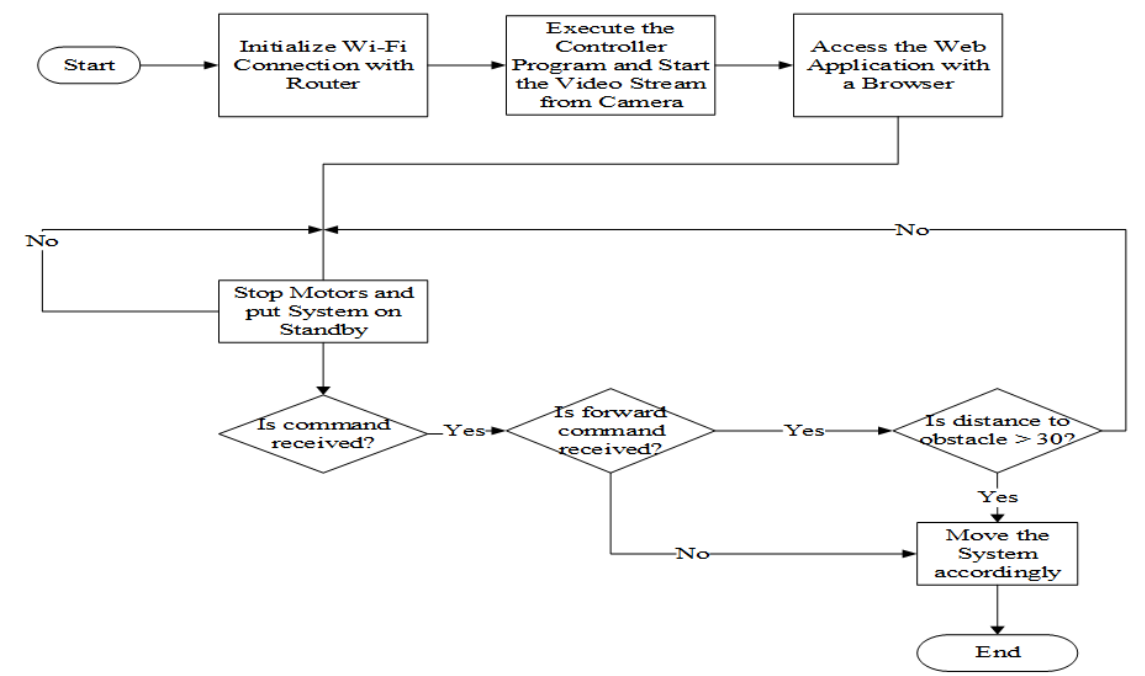
Figure 2. The System